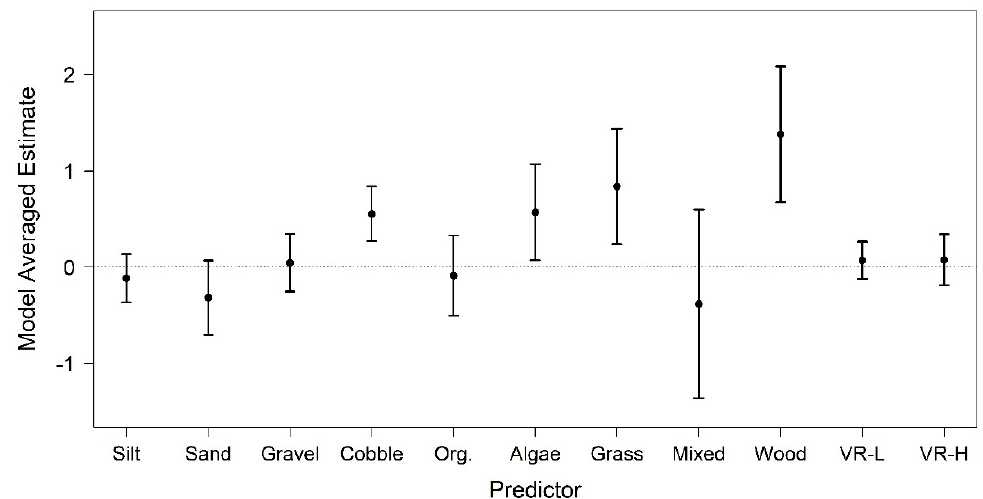
Figure 3. Model-averaged slope parameter estimates for predictor variables from 256 candidate generalized linear mixed models. ‘Grass’, ‘Mixed’, and ‘Wood’ refer to shoreline vegetation types, whereas ‘VR-L’ and ‘VR-H’ refer to low and high aquatic macrophyte richness, respectively. Error bars represent 95% confidence intervals calculated based on unconditional standard errors.